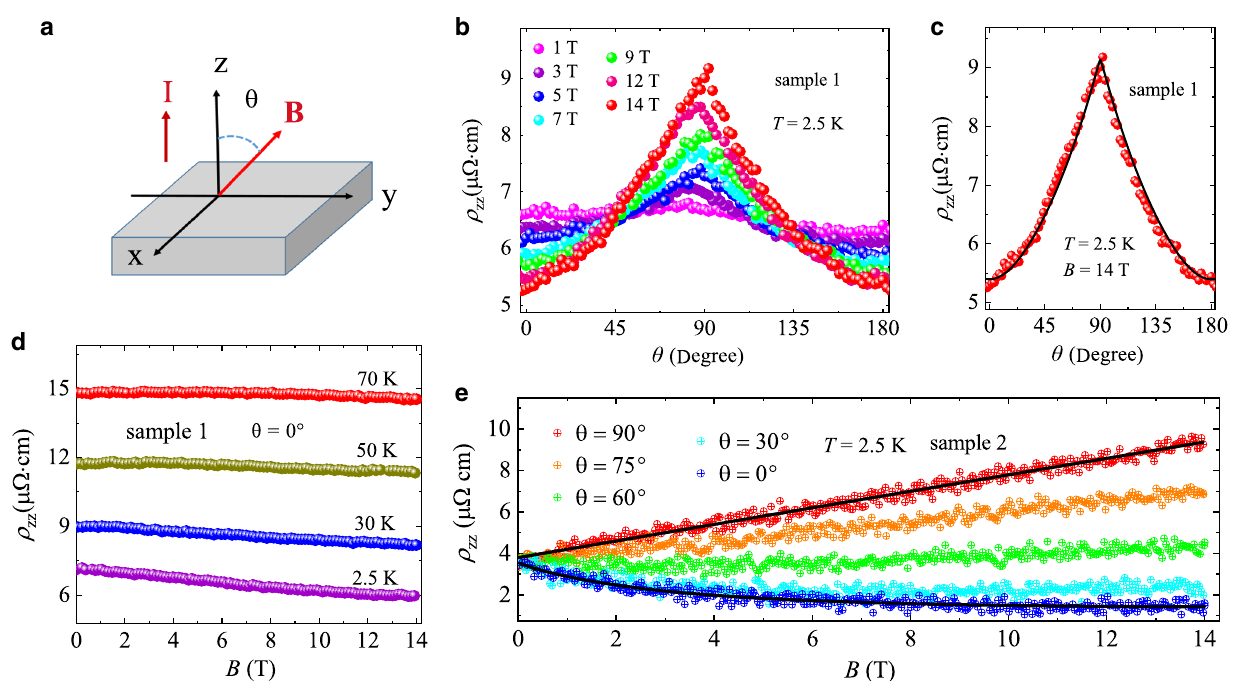
Fig. 6 Interlayer magnetotransport properties of BaGa 2 . a The schematic illustration of interlayer transport experiment setup. I fl ows along c , and θ is the angle between B and I . b Angle dependence of interlayer resistivity ρ zz at 2.5 K under different magnetic fi elds. c Angle dependence of ρ zz at 2.5 K and 14 T (red dots) with the fi tting by Eq. (3) (black line). d and e Field dependence of ρ zz at various temperatures and angles,